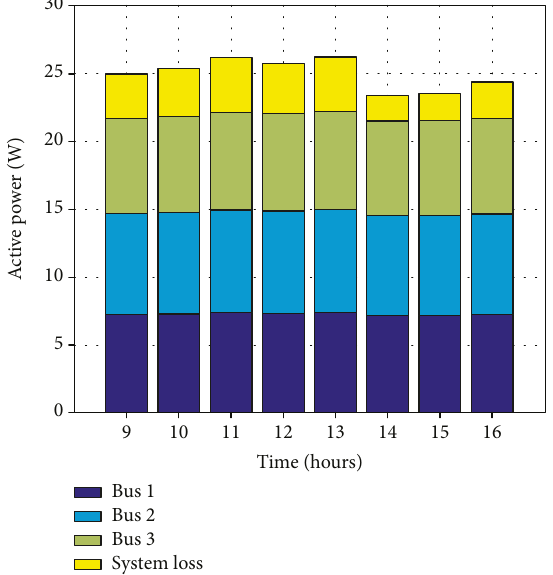
Figure 12: Distributed power in the simulation model of single-source con fi